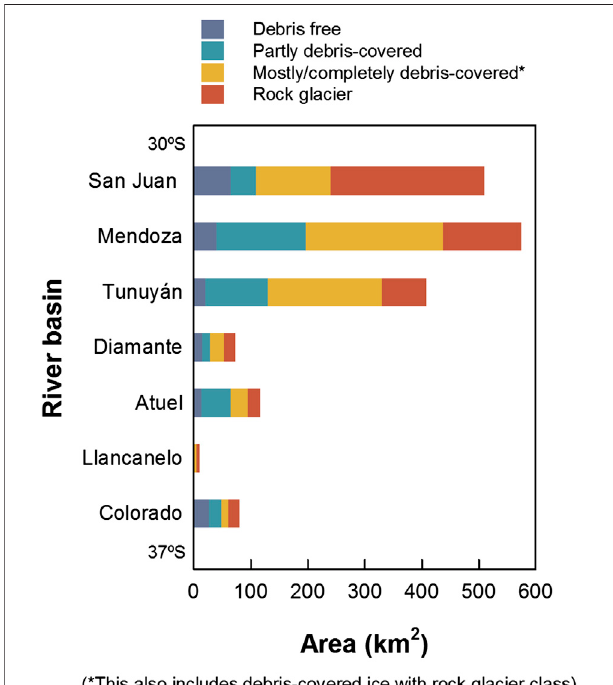
FIGURE 4 | Different debris coverage in glaciers and rock glaciers in the Central Andes basins of Argentina. “ Debris-covered ice with rock glacier ” corresponds to the new category included in the NGI of